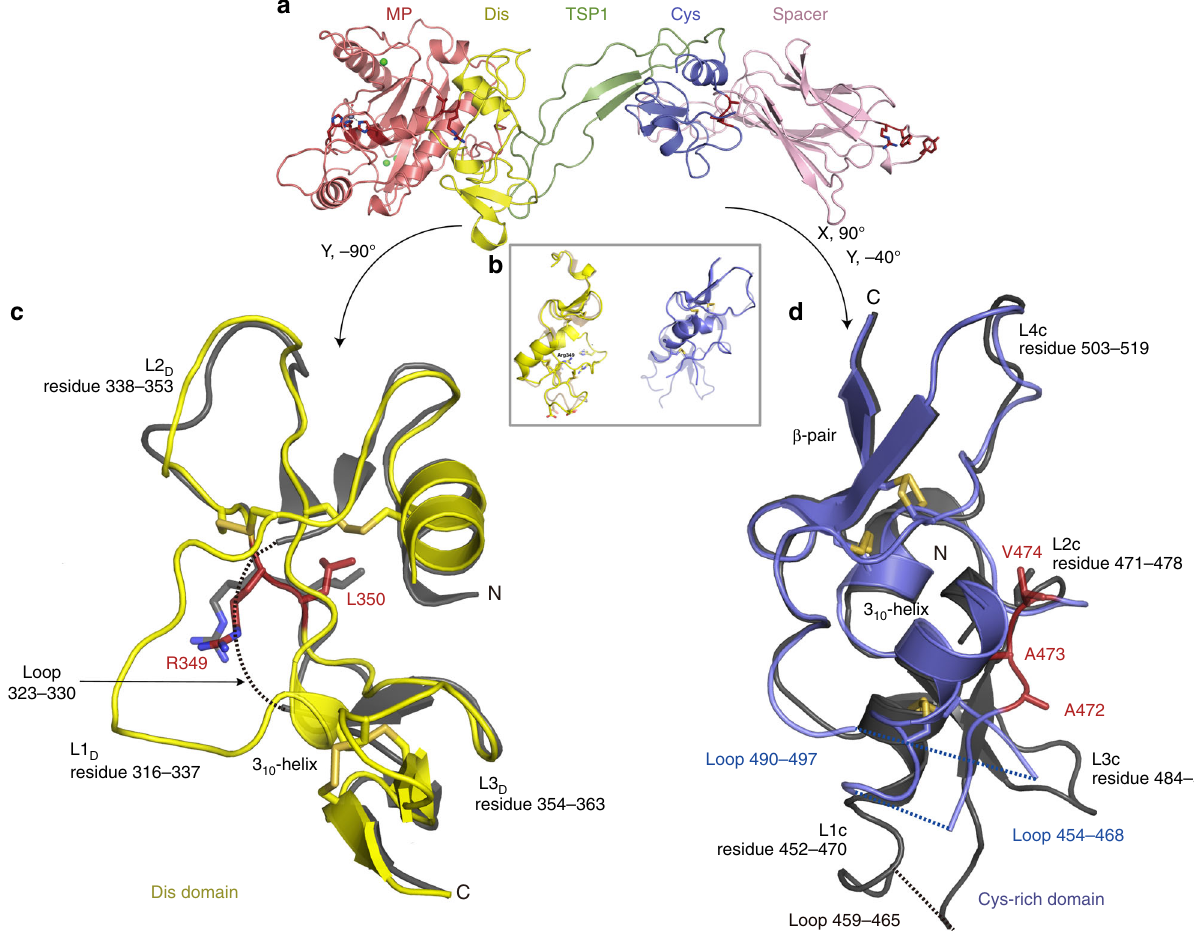
Fig. 5 Comparison of the disintegrin-like (Dis) and cysteine (Cys)-rich domain structures. a Ribbon representation of “ front ” view of MDTCS (MP through to Spacer) with domains labelled/colored. b Dis (yellow) and Cys-rich (blue) domains are shown in the same orientation to reveal their structural homology overlaid on the previous ADAMTS13 DTCS domain structure of these domains. c Dis domain (yellow) overlaid on the previous structure of this domain (gray) with the loops L1-3 D labelled. Dis domain exosite residues Arg 349 and Leu 350 are shown as sticks and highlighted in red. L1 D residues 323 – 330 were missing in the previous DTCS structure of this domain — dotted line. L1 D is connected to L2 D (Cys 322 -Cys 347 ) and a β -strand (Cys 332 - Cys 366 ), L2 D has additional connection with the α -helix (Cys 311 -Cys 337 ), and L3 D is linked with the other β -strand by Cys 360 -Cys 371 . d Ribbon representation of ADAMTS13 Cys-rich domain (blue) overlaid on previously determined DTCS domain structure (gray). Loops L1-4 C are labelled. Cys-rich domain exosite residues Ala 472 -Val 474 are shown as sticks and highlighted in red. Unlike L1 D , L1 C and L2 C are free of disul fi de bonds and there is a small α - helix at the end of L2 C . This small 3 10 helix is linked with the β -strand by a disul fi de bond (Cys 483 -Cys 522 ). L3 C , connected with the main α -helix by Cys 450 - Cys 487 , starts from the end of small α -helix and extended to L4 C . L4 C has a link with the β -strand by Cys 508 -Cys 527 . Unresolved residues from the